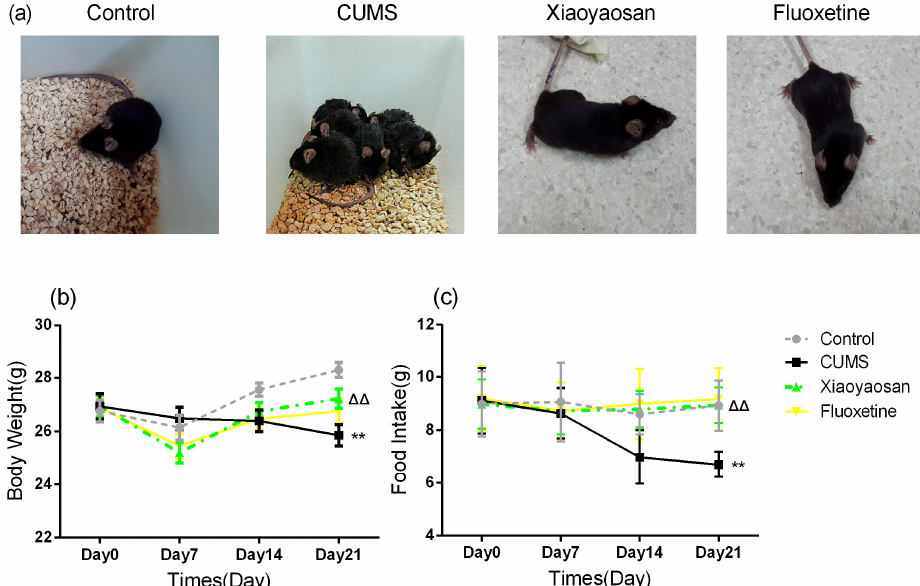
Figure 1. ( a ) Physical condition of mice in all groups was observed at the end of modeling; ( b ) Body weight was recorded once a week during the modeling period; ( c ) Food intake was recorded once a week during the modeling period. Data were expressed as means ± SEM ( n = 15), ** p < 0.01 versus control group; ΔΔ p < 0.01 versus CUMS group.